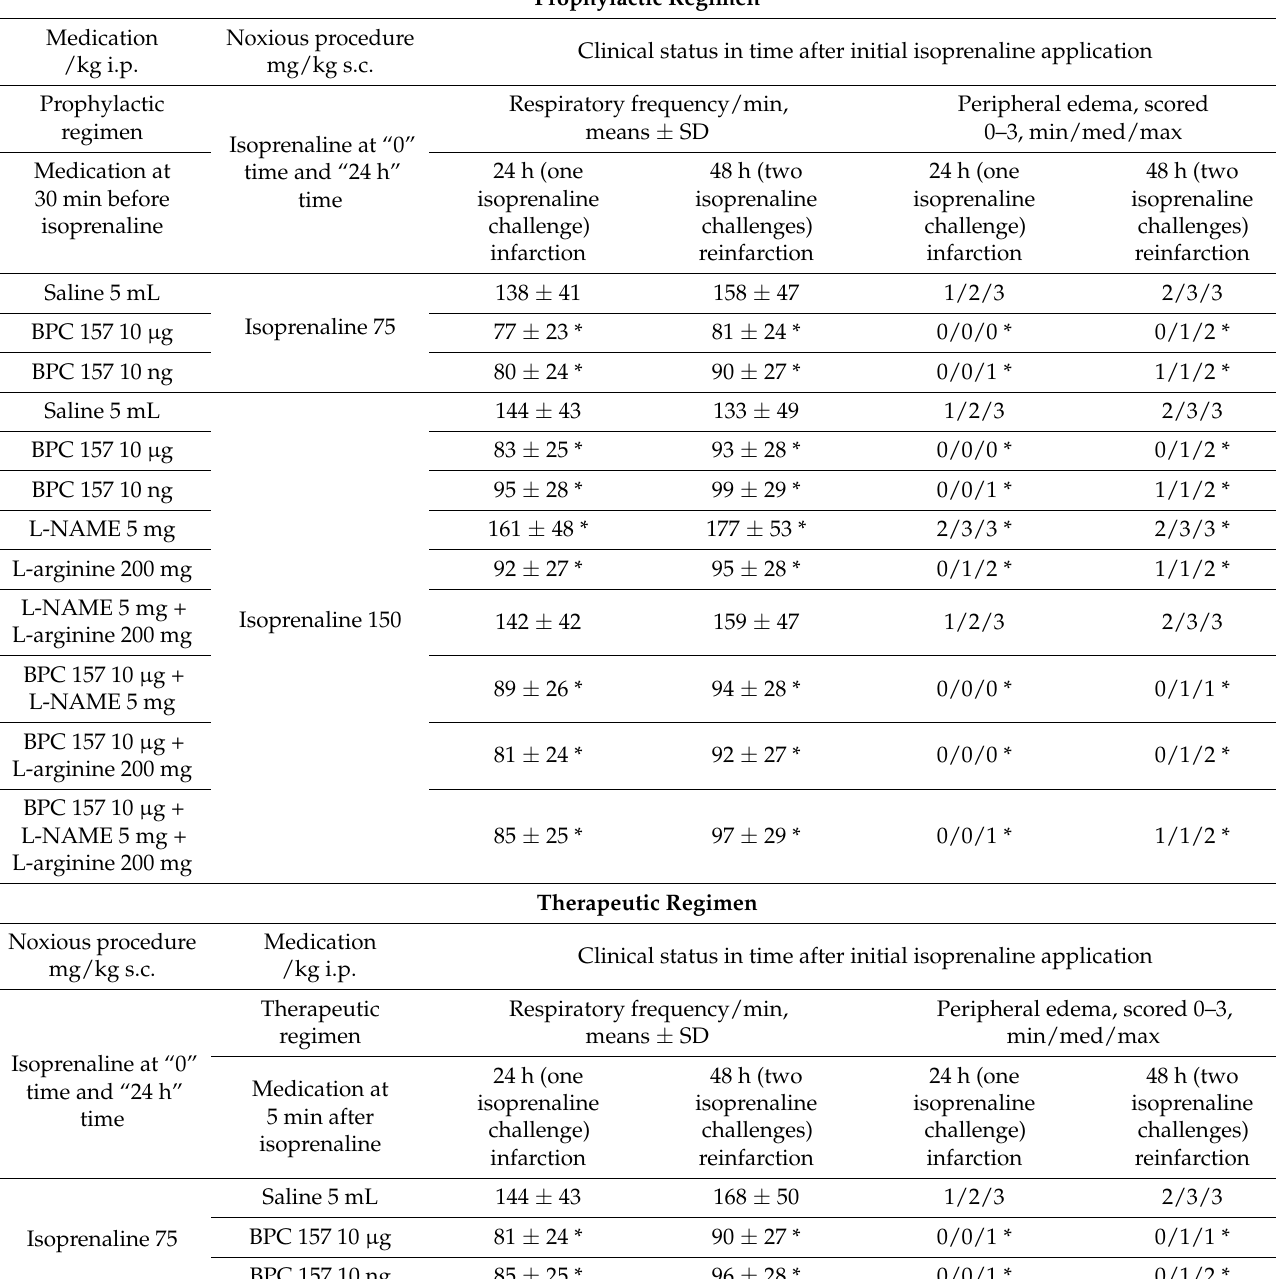
Table 2. Clinical presentation, respiratory frequency/min (means ± SD); peripheral edema (scored 0–3, min/med/max) in isoprenaline-treated rats treated with BPC 157, L-arginine, and L-NAME, given alone or together. Prophylactic regimen. Therapeutic regimen. Isoprenaline (75 mg/kg or 150 mg/kg s.c., given once (at time 0) or twice, at 0 and 24 h). First challenge for initial infarction induction, assessed at 24 h thereafter; then, at 24 h, the next application (isoprenaline given twice, at 0 and 24 h) for reinfarction induction (assessment at the end of the subsequent 24 h period). Medication (/kg, i.p.) (BPC 157 (10 µ g, 10 ng), L-NAME (5 mg), L-arginine (200 mg) (given alone or together) or saline (5 mL) (control)) at (i) 30 min before; or, alternatively (ii) at 5 min after isoprenaline. * Means ± S.D. vs. control, at least p < 0.05, 10 rats per each experimental